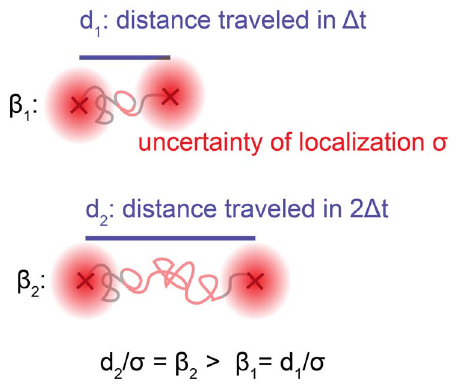
Figure 2. Validation of tracking function on simulated data. The fraction of detected particles and fully reconstructed tracks (number of true positives/ground truth (GT)) as a function of the ratio of the average nearest neighbor distance over the average displacement a/d . Image stacks with 150 particles were simulated over 30 frames. In the first image frame particles were located at a distance 5 6 radius of Airy disk from each other and then moved assuming Brownian motion in subsequent frames. d was varied. Each data point shows the mean value of 50 repetitions.